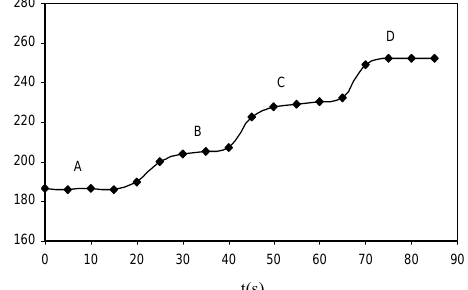
Figure 4. The dynamic response time of the terbium electrode for step changes in the Tb 3+ concentration: A) 1.0 × 10 -5 M, B) 1.0 × 10 -4 M, C) 1.0 × 10 -3 M, D) 1.0 × 10 -2